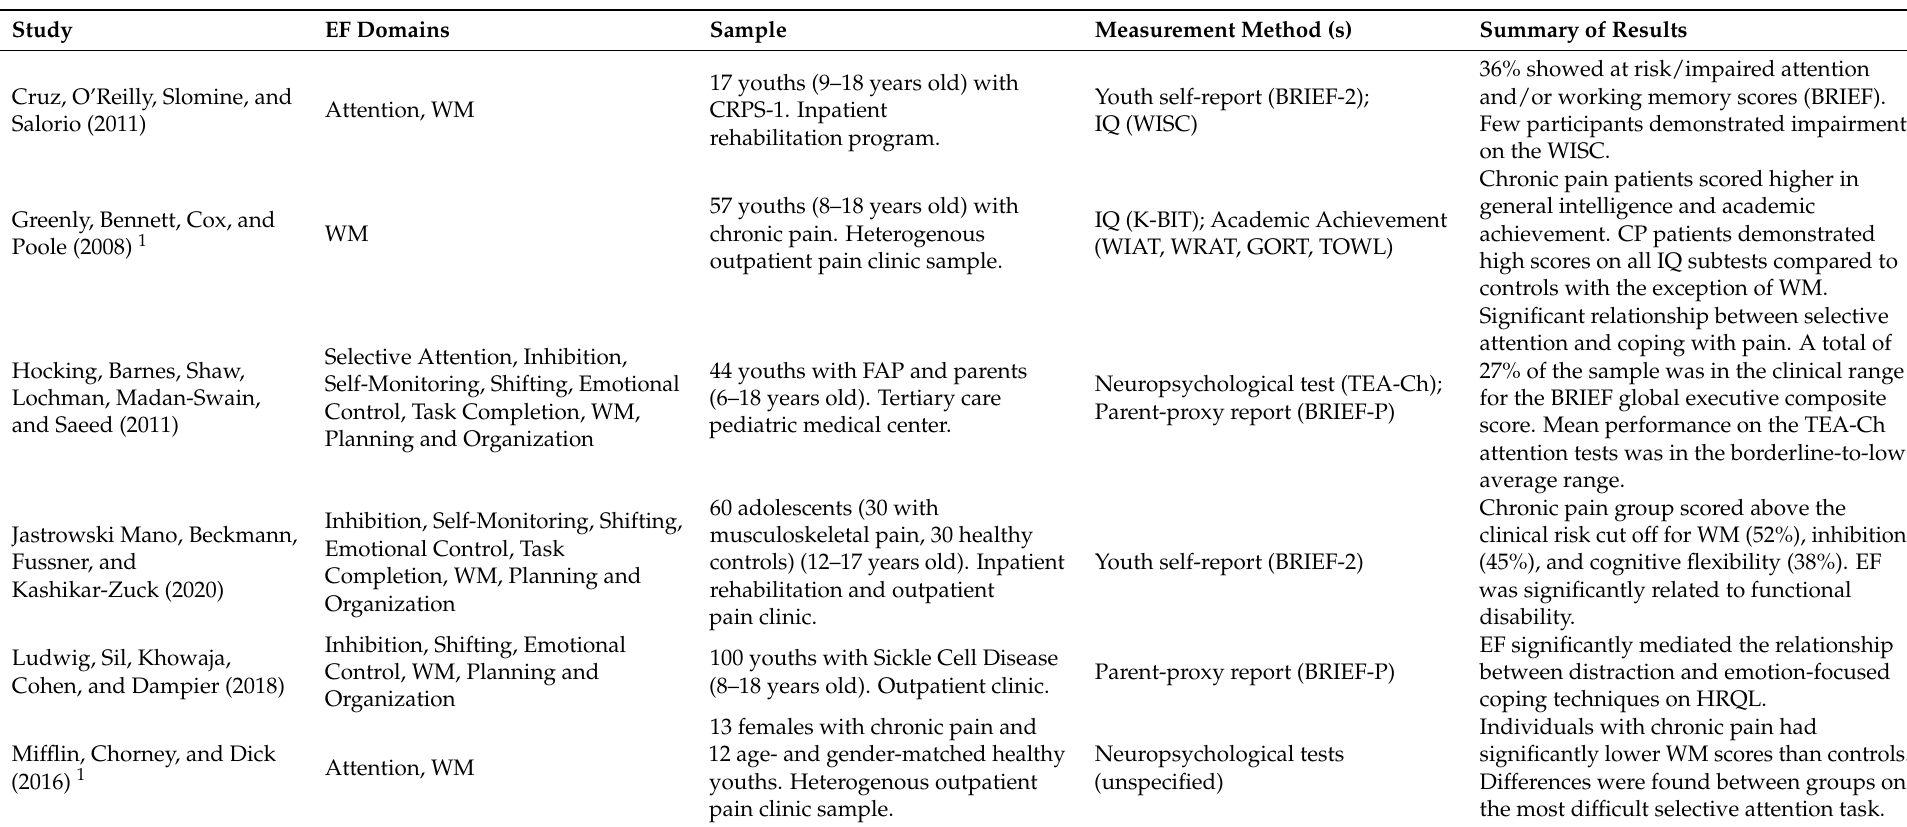
Table 1. Measurement of EF in Pediatric Chronic